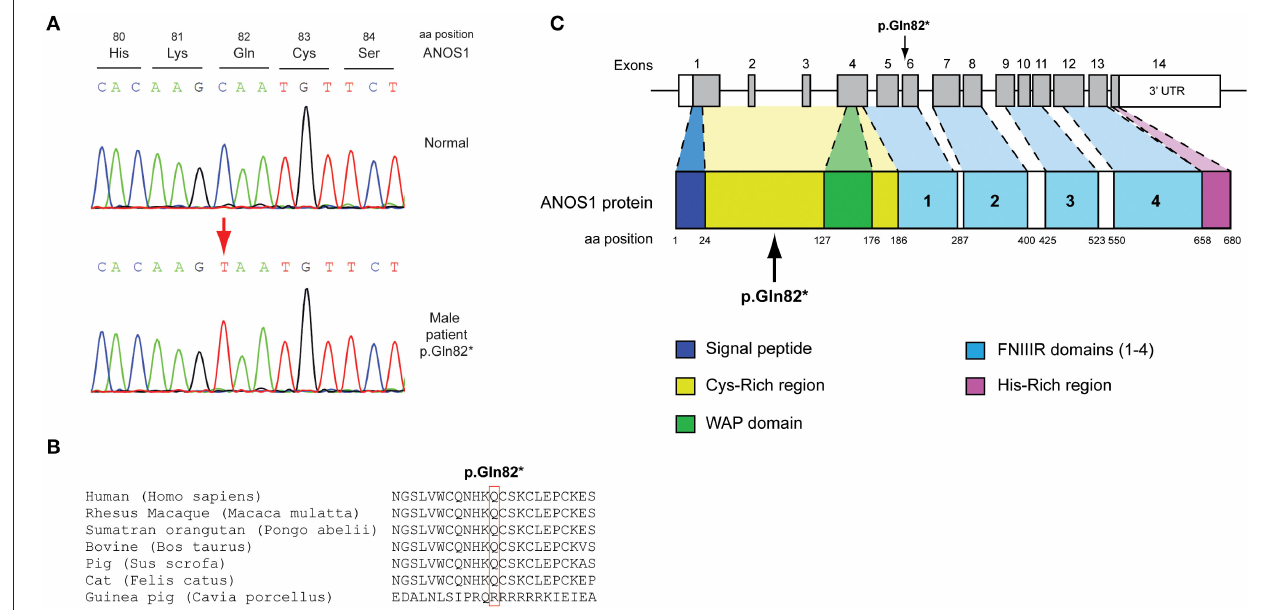
FIGURE 1 | Identification of a novel p.Gln82* ANOS1 mutation. (A) Sequence electropherogram of the novel p.Gln82* ANOS1 mutation. (B) Multiple sequence alignment of the amino acid at position 82 of the ANOS1 protein from various species. The conserved glutamine amino acid at position 82 is indicated by red color. (C) Schematic representation of the ANOS1 gene and protein of a male patient identified with the novel p.Gln82* non-sense pathogenic variant. WAP, whey acidic protein; FNIII, fibronectin type III.